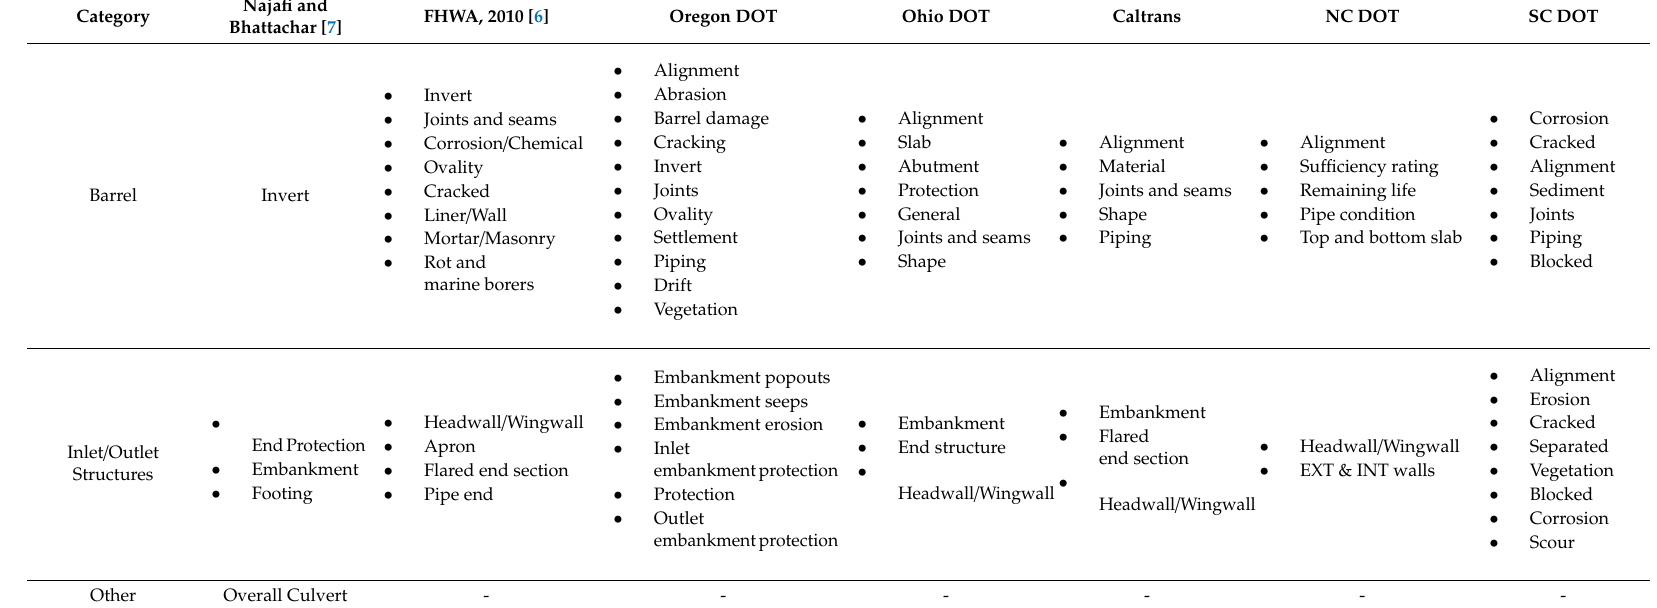
Table 1. Comparison of culvert parameters rated by di ff erent